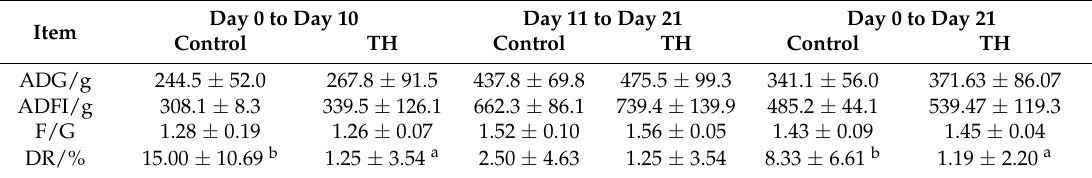
Table 1. The growth performance of piglets receiving dietary supplementation with or without trihexanoin